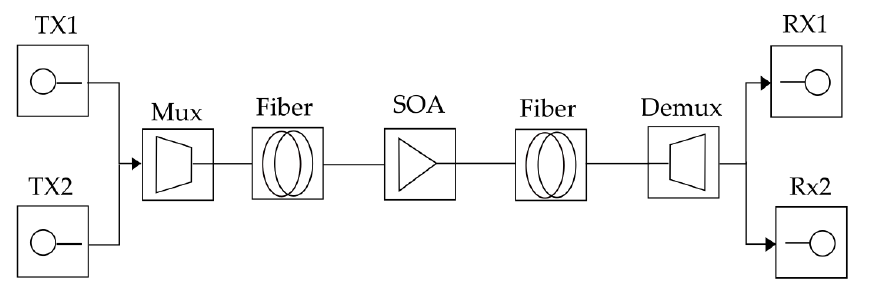
Figure 8. SOA amplifier scheme in optical system.